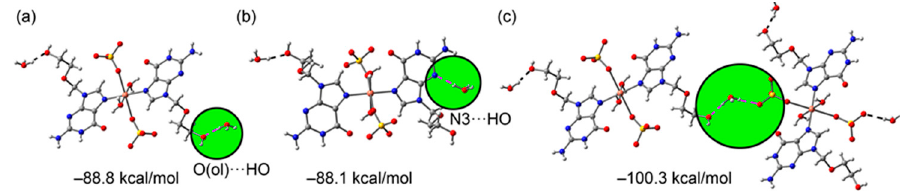
Figure 4. Theoretical models used to evaluate the electrostatic assisted H-bonding interactions in the solid state of compound 1 . ( a ): Interaction of H 3 O + with O(ol) atom of acv; ( b ): Interaction of H 3 O + with N3 atom of acv; ( c ): Interaction of H 3 O + with O(ol) of acv and O-Sulfate atom.